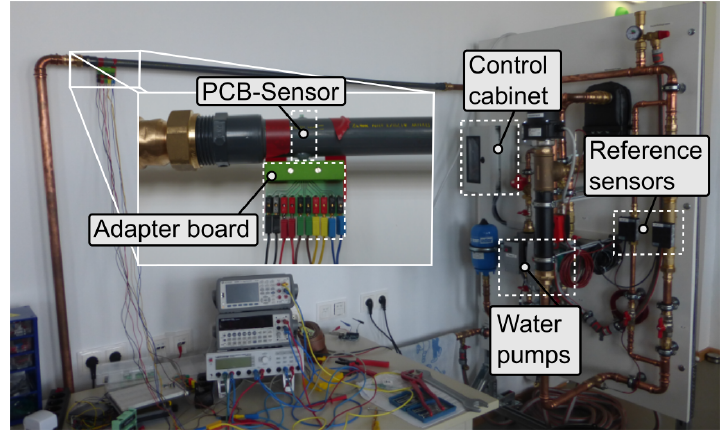
Figure 12. Picture of the water experimental setup. The sensor is stretched across a PVC water pipe (inner diameter of 21.2mm), located at 135cm at a strait pipe which is 20cm before a bend, and connected to the controller by an adapter board. The volumetric flow is controlled via two separate water pumps and measured with two ultrasonic flow sensors. From a control cabinet, all sensors and actuators are controlled.